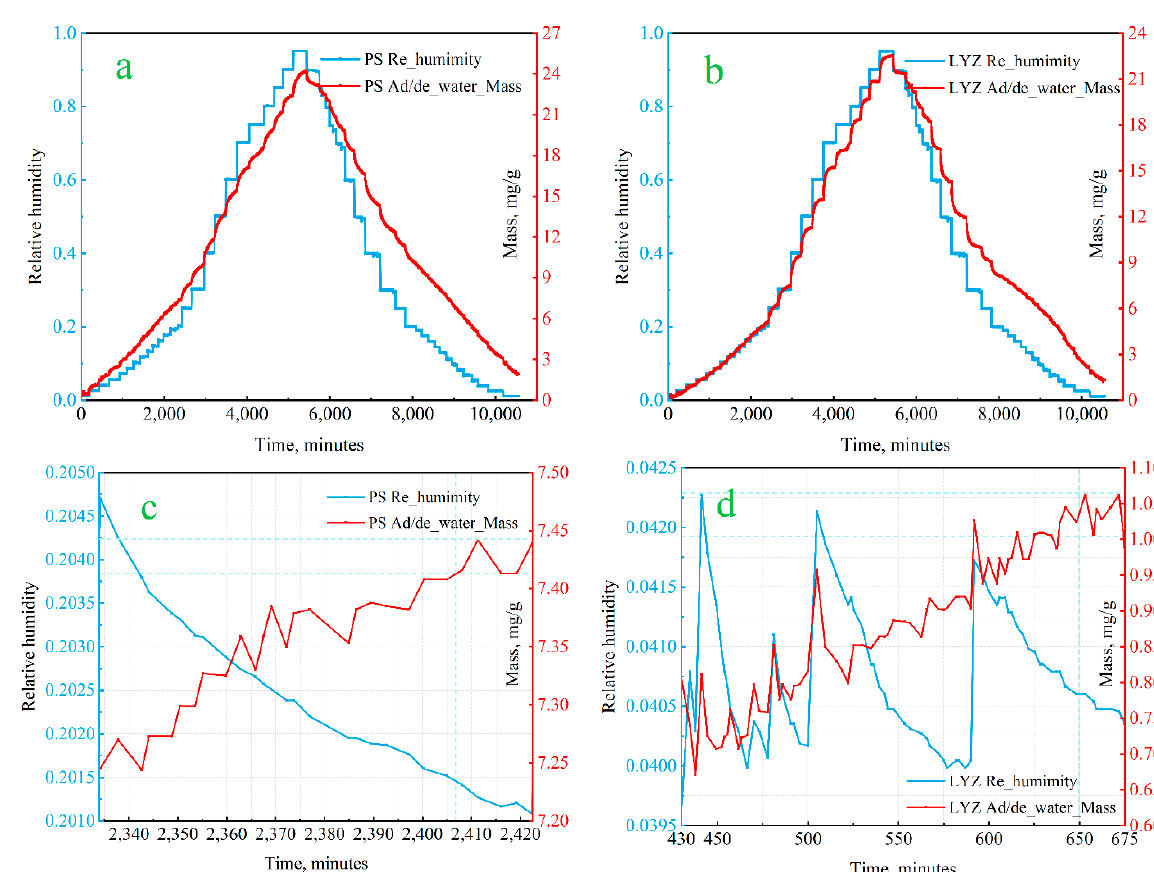
Figure 5. Changes in the quality and relative humidity of the adsorption/desorption in three coal samples with time.